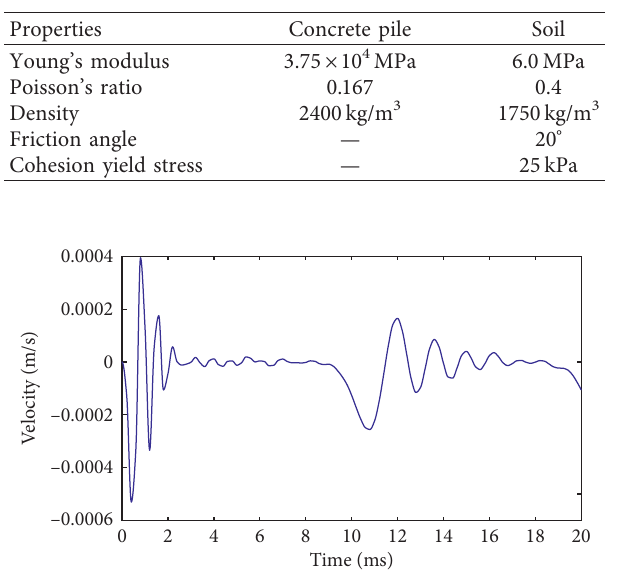
Figure 4: Velocity response